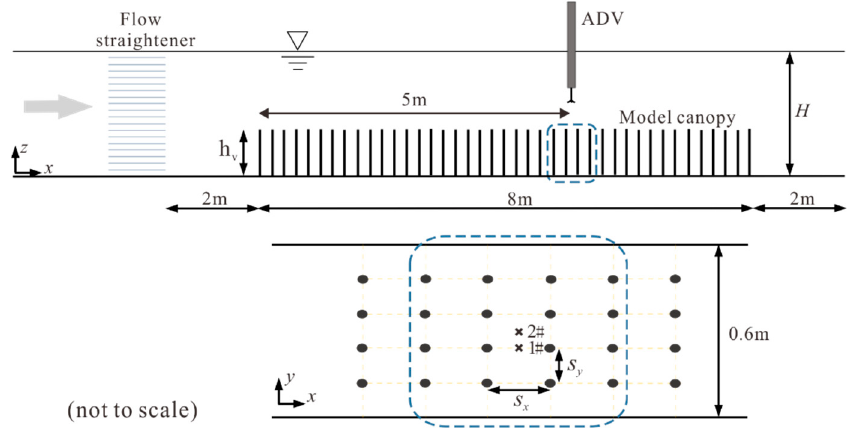
Figure 1. A schematic of the experimental setup and measurement sections.